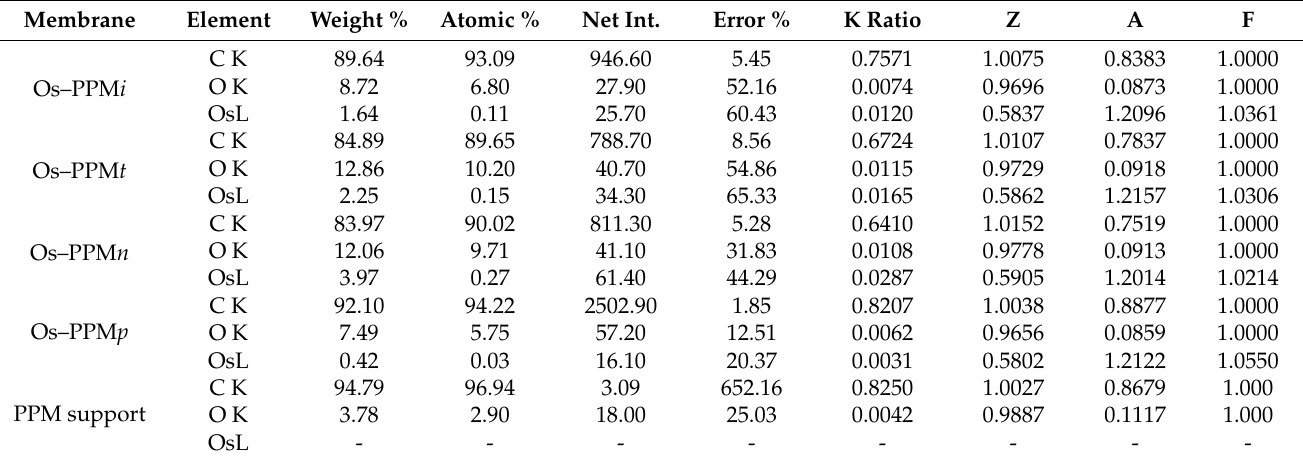
Table 1. Surface analysis for the obtained osmium nanoparticle–polymer composite